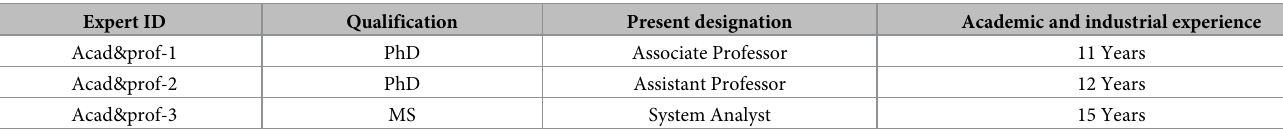
Table 4. Details of focus group meeting